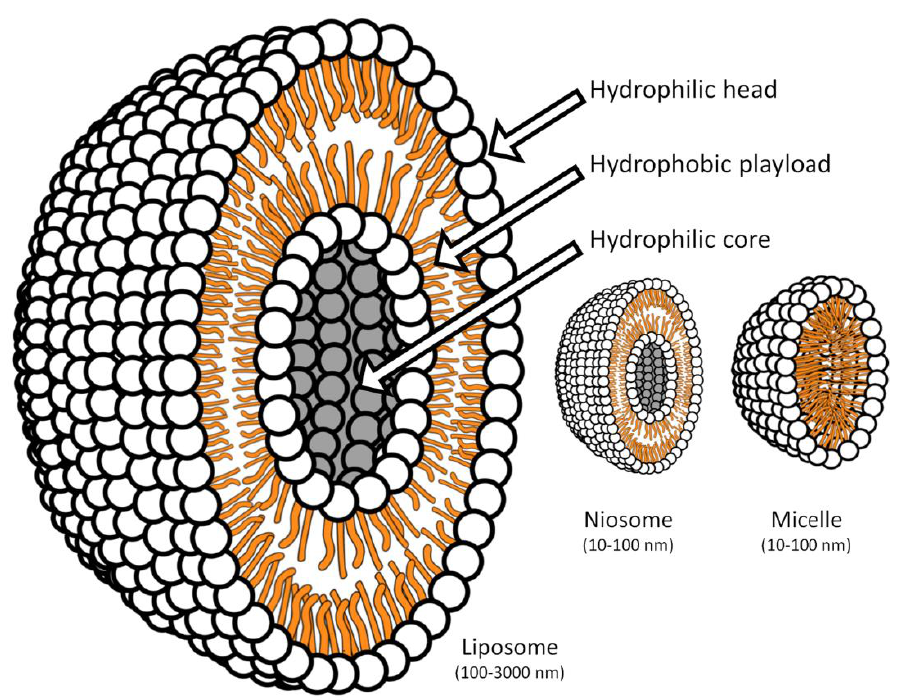
Figure 2. Scale representation of the central section of liposomes, niosomes and micelles.